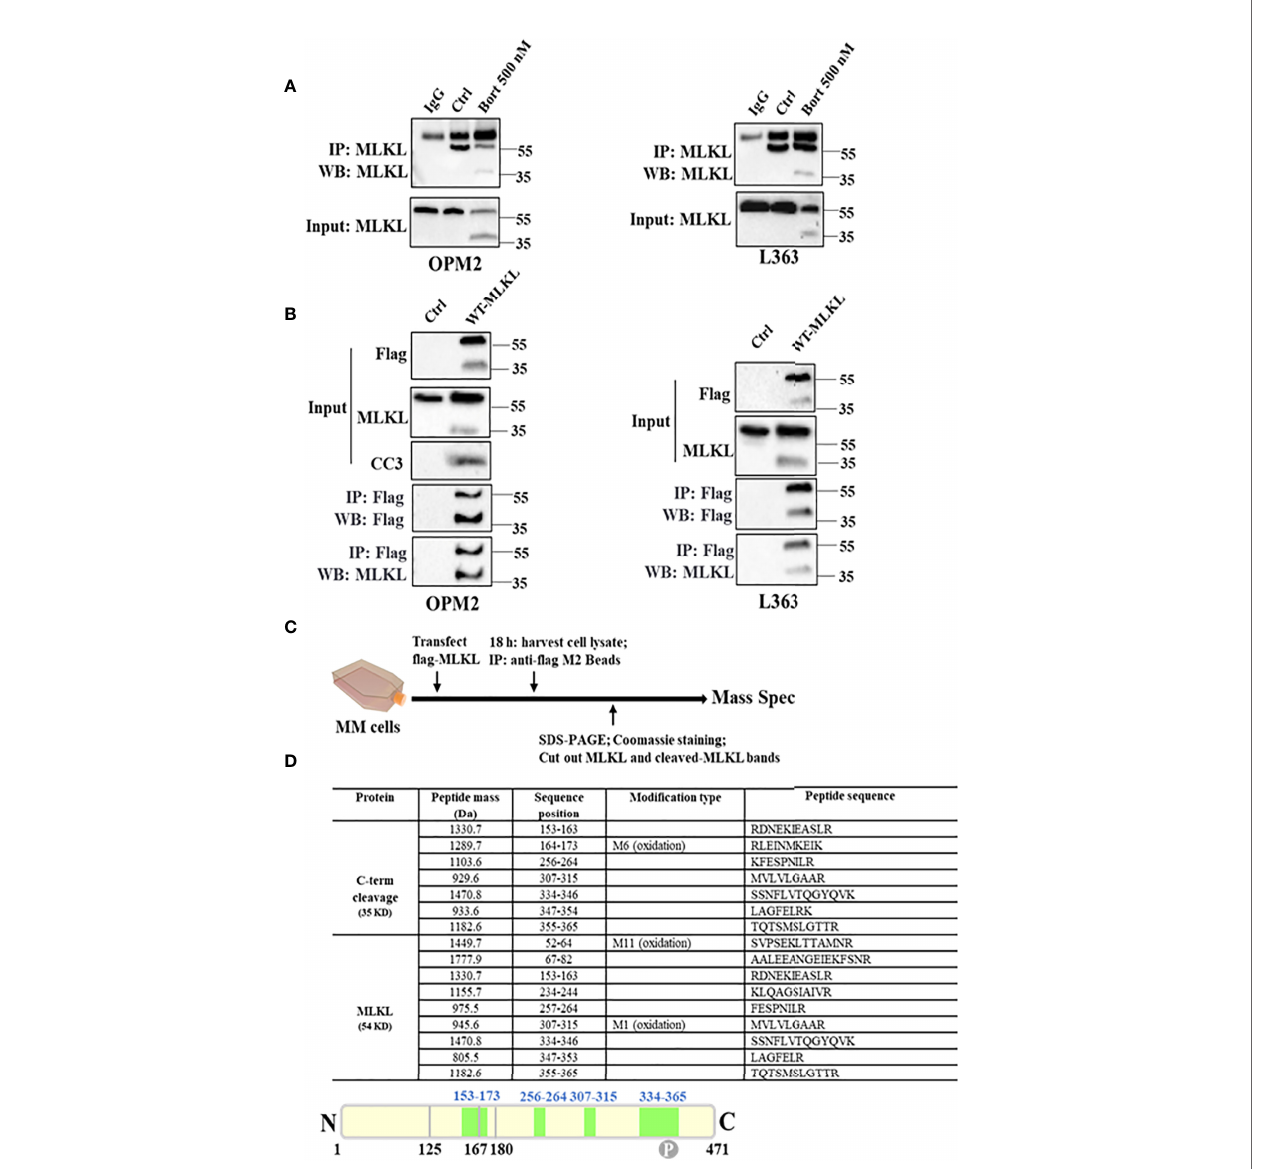
FIGURE 3 | MLKL is indeed cleaved upon cell death induction in MM cells. (A) Endogenous MLKL immunoprecipitates prepared from DMSO or bortezomib-treated OPM2 and L363 cells were analyzed by western blotting with antibody for C-terminus. Protein G Dynabeads with lysis buffer was used as negative control and the detected band around 55 kDa was the IgG heavy chain. The input lysates were also analyzed by western blotting. (B) OPM2 and L363 cells were transiently transfected with 5 µg C-terminal Flag-MLKL vector encoding wild-type MLKL. After 18 h, exogenous MLKL was immunoprecipitated from transfected or non- transfected cells with anti-Flag M2 beads. The input lysates and immunoprecipitates were analyzed by western blotting with indicated antibodies. (C) Outline of MLKL cleavage study experiment. Exogenous MLKL immunoprecipitates obtained as described in (B) were subjected to reducing SDS-PAGE and proteins were stained with Coomassie stain. Then, total MLKL and C-terminus bands were excised and performed for mass spectrometric analysis. (D) Identi fi ed Peptides from total MLKL and C-terminus by mass spectrometric analysis. M, the speci fi c amino acid was modi fi ed by